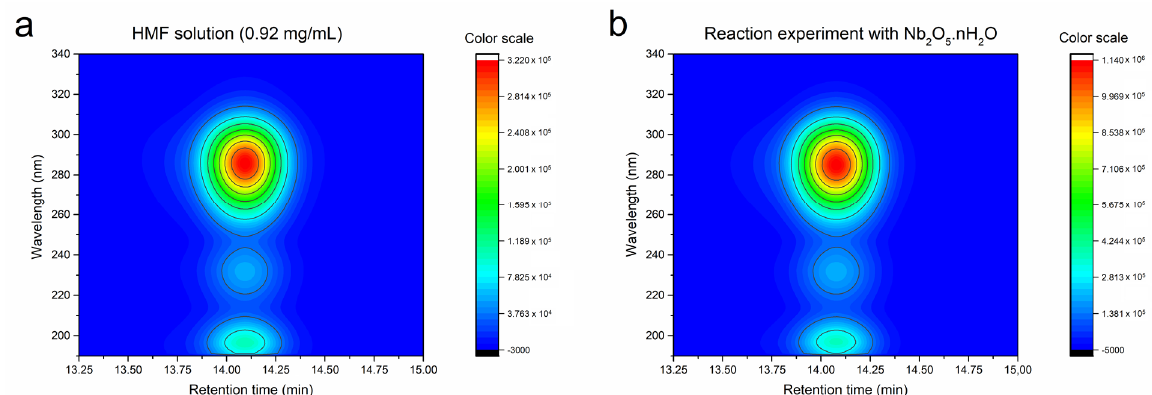
Table 1. Conversion (fructose), selectivity and yield (HMF) for the different catalysts in aqueous solution a .